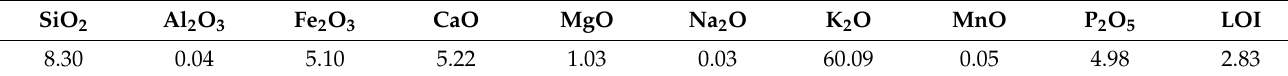
Table 3. Chemical composition (%) of the dry CHA.